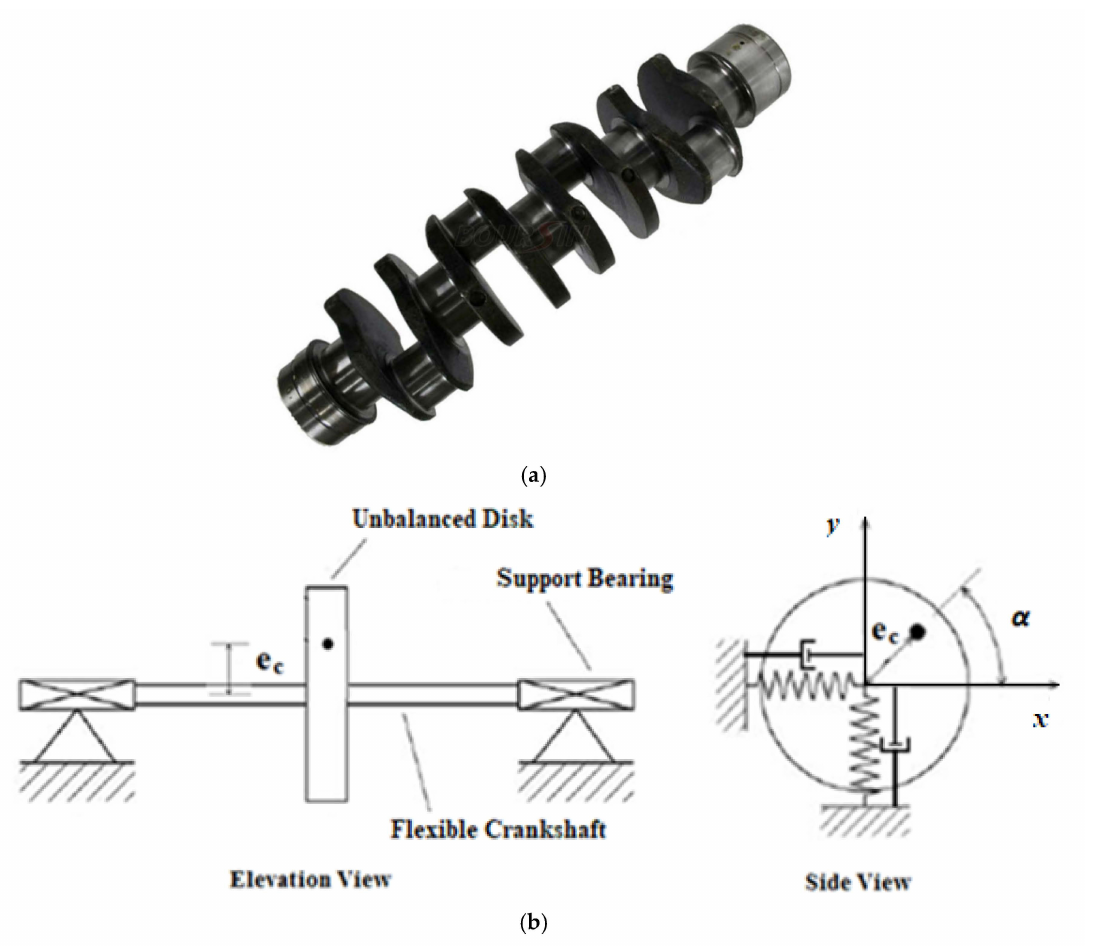
Figure 2. ( a ) A diesel four-cylinder engine crankshaft, Isuzu NPR NPS Truck 4HG1 Diesel Engine; ( b ) Schematic diagram of a flexible crankshaft of single-cylinder engine with